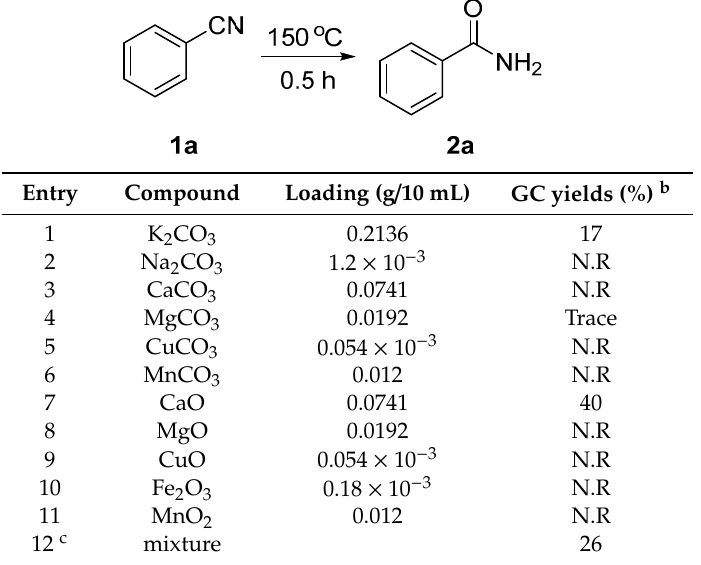
Table 5. The conversions of 1a in the water solutions of different inorganic carbonates or oxides a .